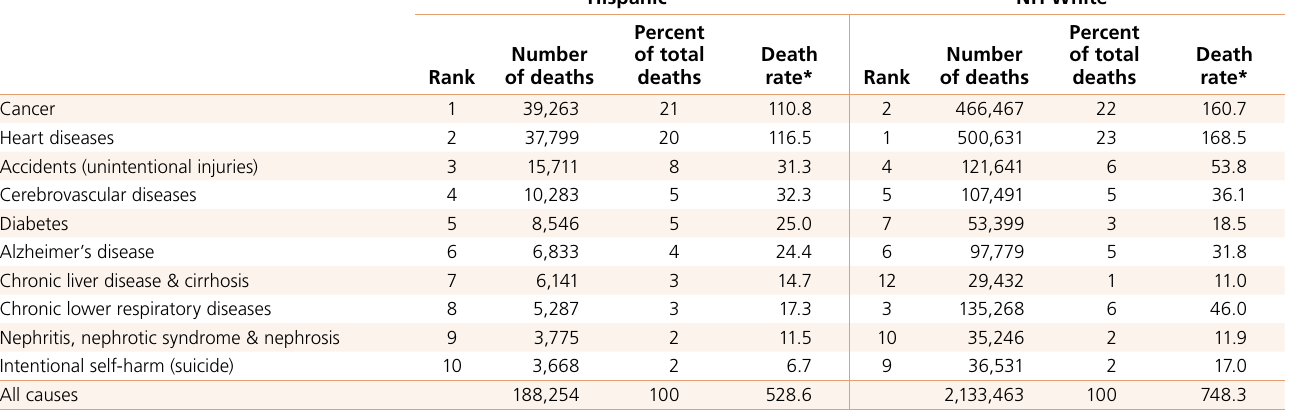
Table 2. Leading Causes of Death among Hispanics and Non-Hispanic Whites, US,